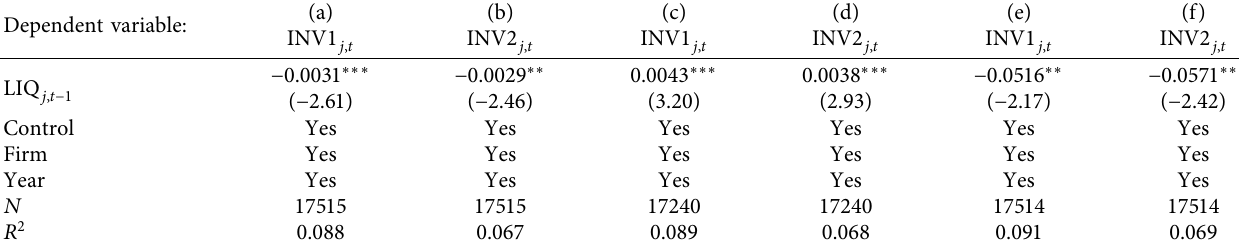
Table 9: Homogeneous index substitution test.